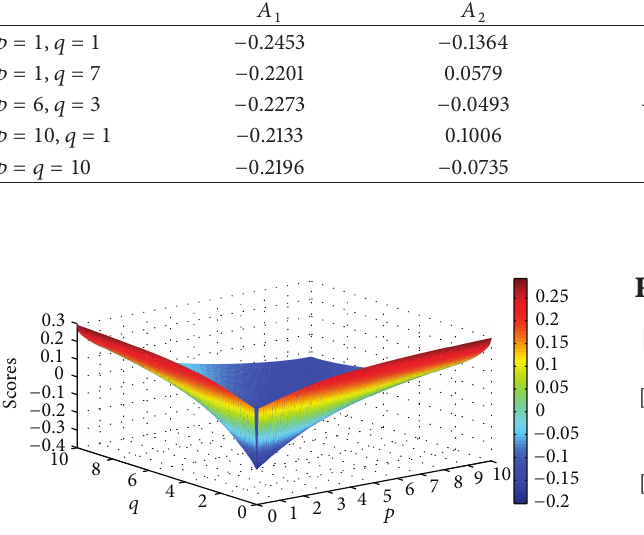
Figure 11: Scores for District 𝐴 3 obtained by the IIFWBM operator (𝑝 ∈ (0, 10],𝑞 ∈ (0,10]) .